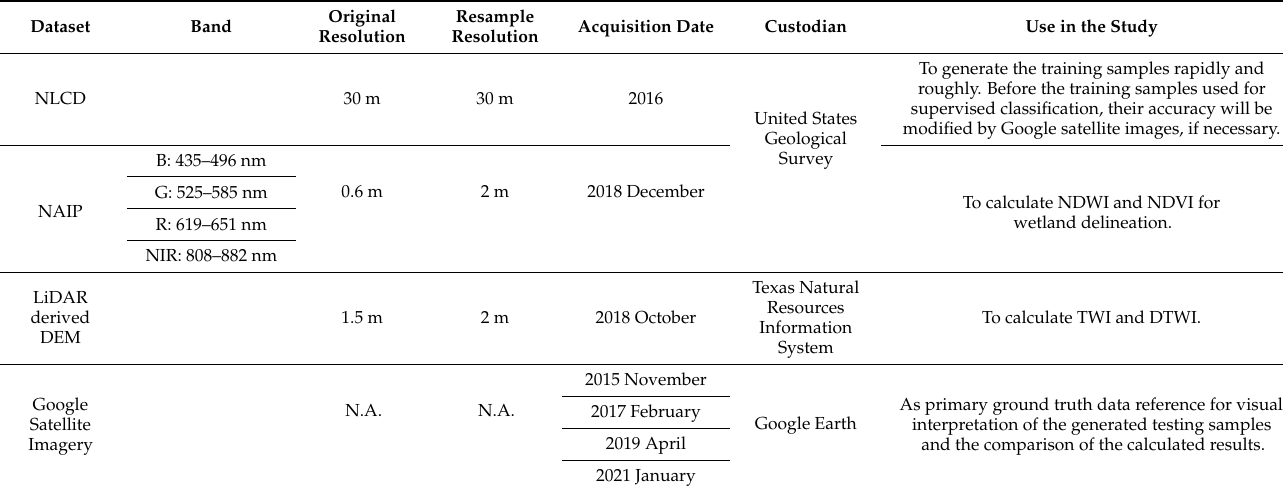
Table 1. The information of datasets and their usage for the